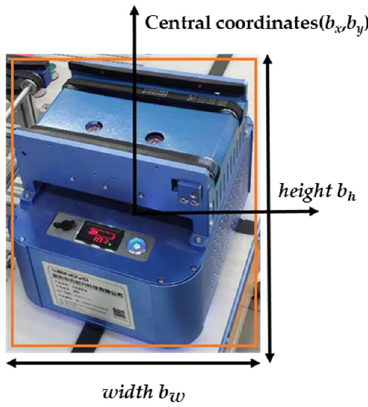
Figure 7. Parameters generated during dataset